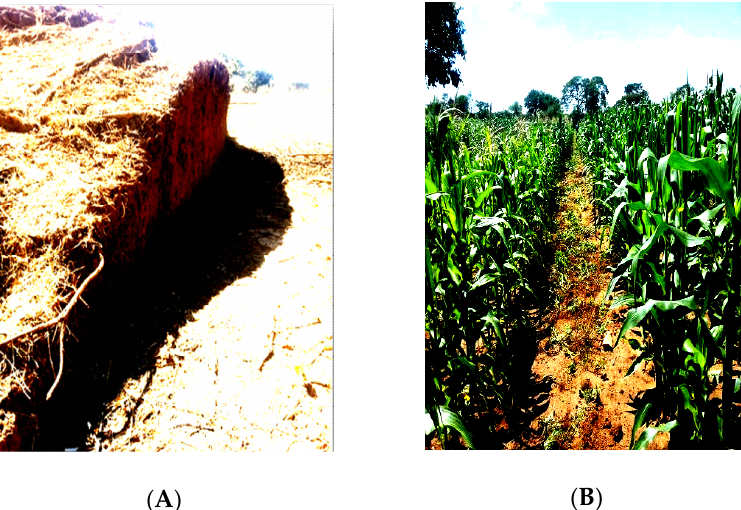
Figure 4. ( A ) Part of cut termite mound soil applied for fertility improvement; ( B ) Maize crop under termite mound soil treatment as part of integrated nutrient management in a conservation agricultural system, Southern Zambia.